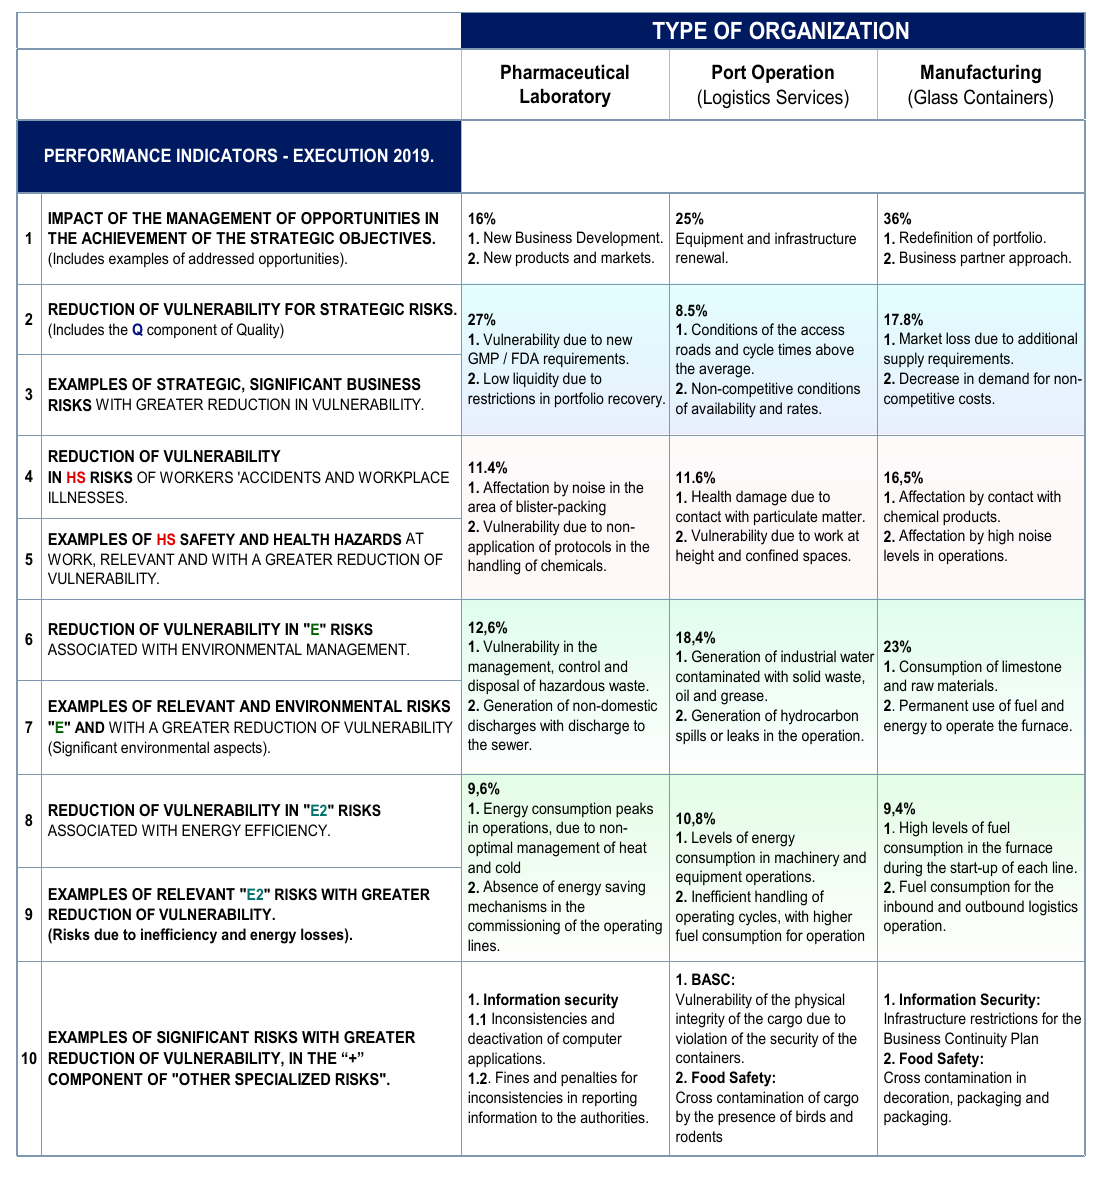
Figure 13. Indicators of vulnerability reduction and incidence of opportunity management in the achievement of strategic objectives: Companies 4, 5, and 6.